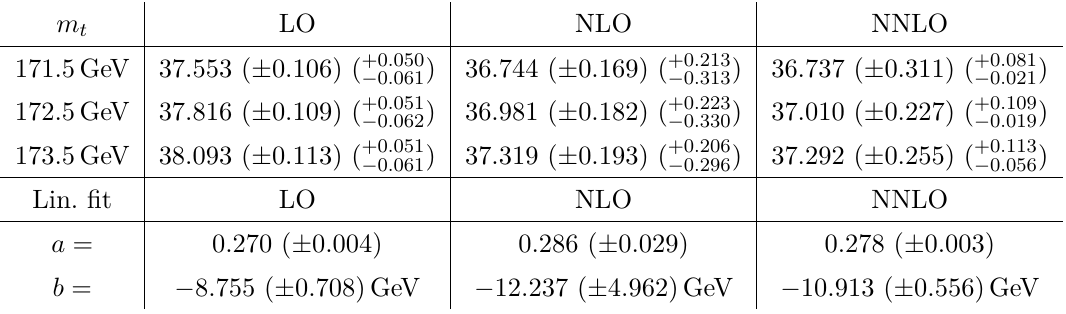
Table 3 . As in table 2 but for LO top quark